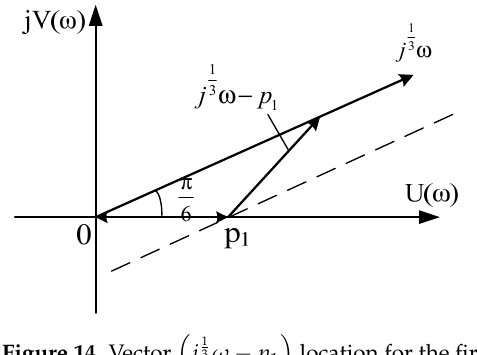
(cid:3117) Figure 14. Vector (𝑗 (cid:3119) 𝜔 − 𝑝 (cid:2869) ) location for the first root when 𝜔 𝜖 (0, ∞) .